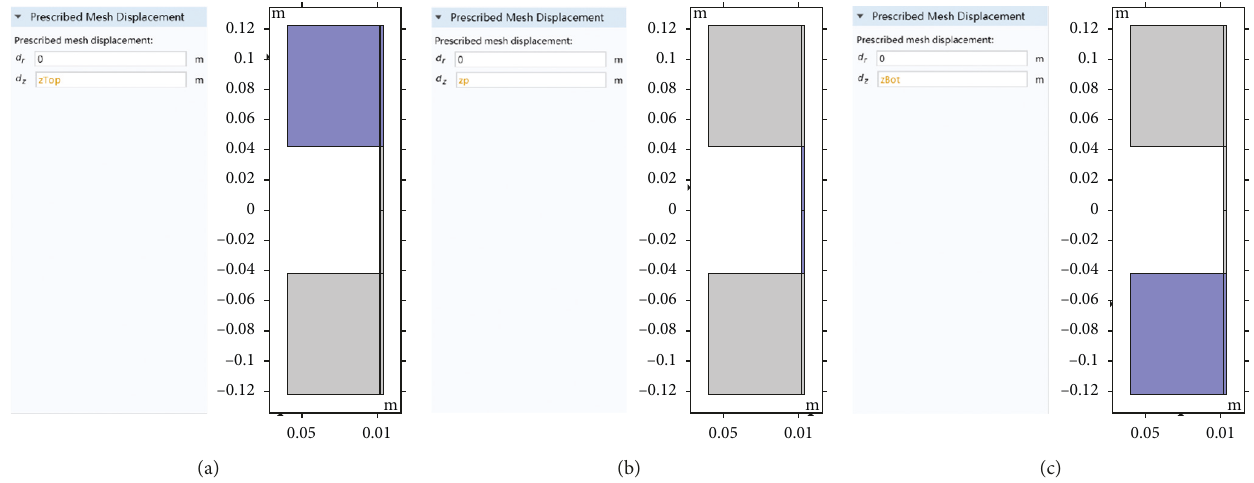
Figure 7: Input of mesh motion equation in COMSOL. (a) Top chamber. (b) Working gap. (c) Bottom